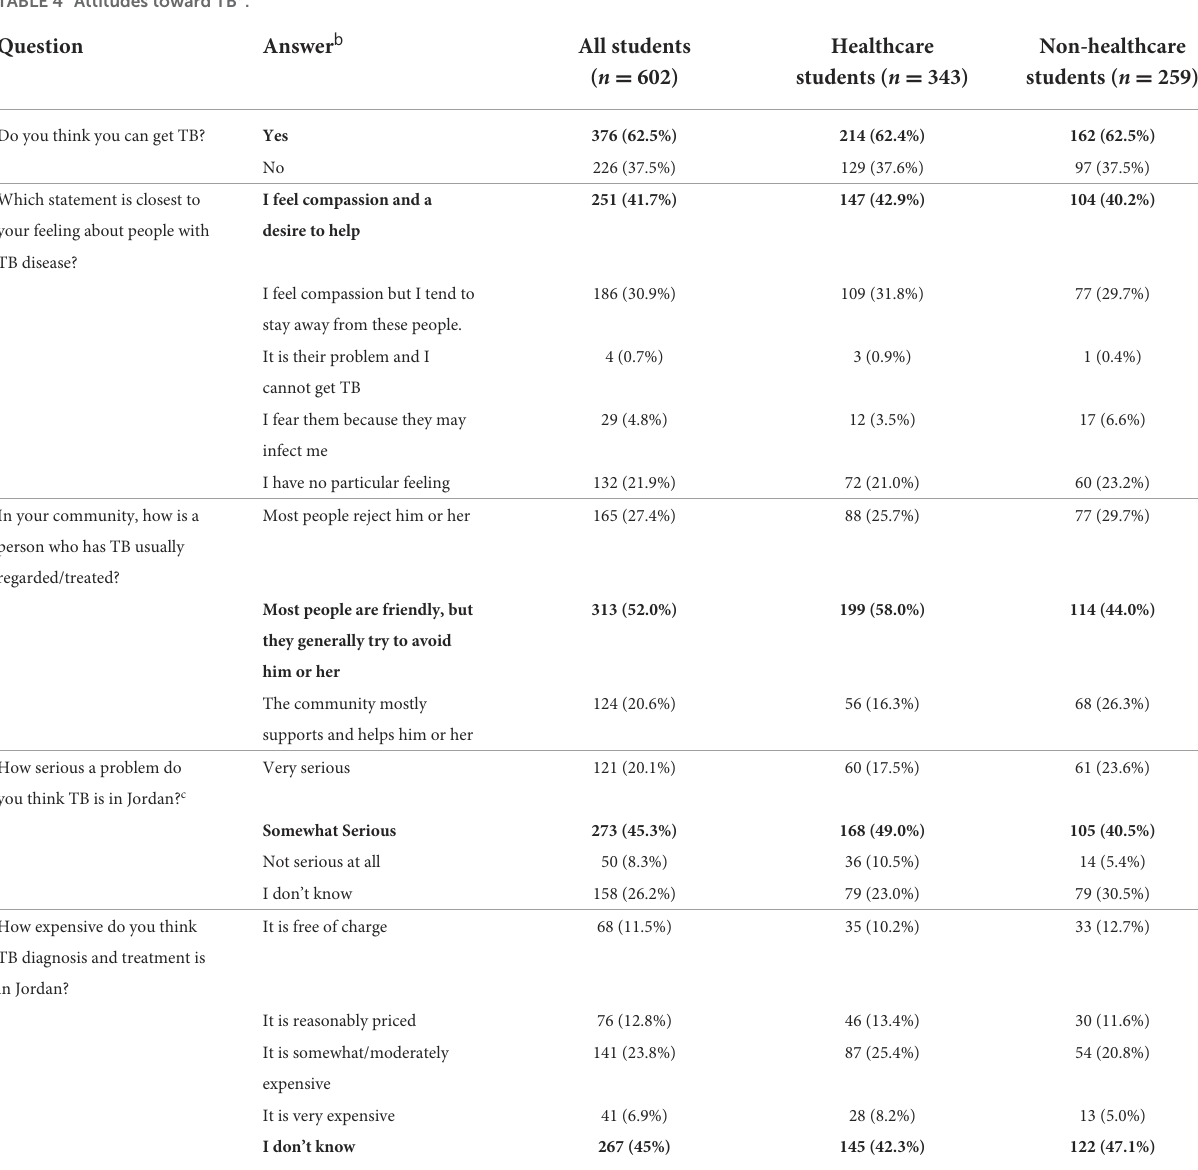
TABLE 4 Attitudes toward TB a